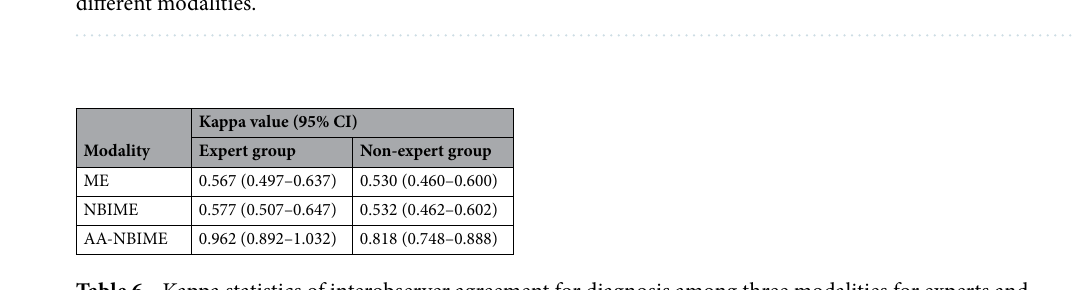
Table 6. Kappa statistics of interobserver agreement for diagnosis among three modalities for experts and non-experts.